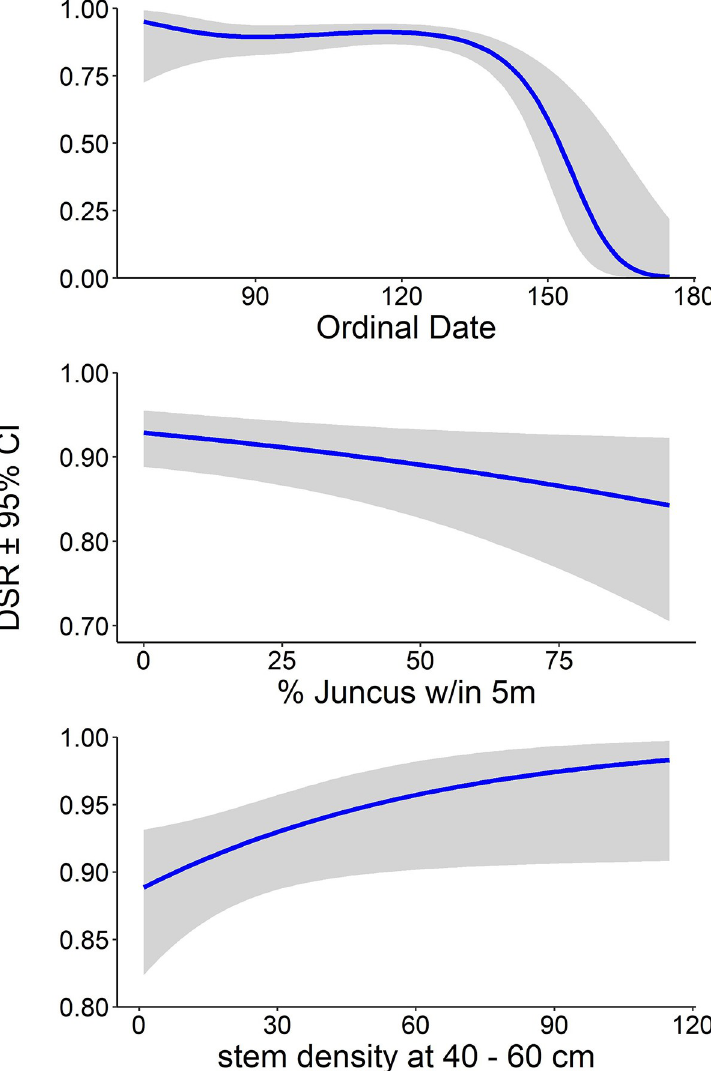
Fig 4. Daily nest survival rates ( ± 95% confidence intervals) of Seaside Sparrows in Louisiana 2012–2017 as a function of Day (ordinal date) of nest initiation (top), % Juncus within 5 m of the nest (middle), and stem densities near the nest in the 40–60 height stratum (bottom). Predicted estimates are derived from the top performing model of daily survival rates, using means for continuous variables, Year cat = 2017, and Bay =